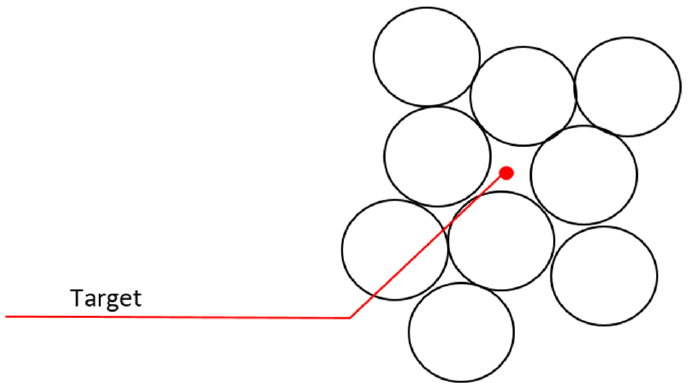
Figure 9. Inability of the individuals in the swarm to reach the target. Algorithm 4 Solution: When the target is given to the robots